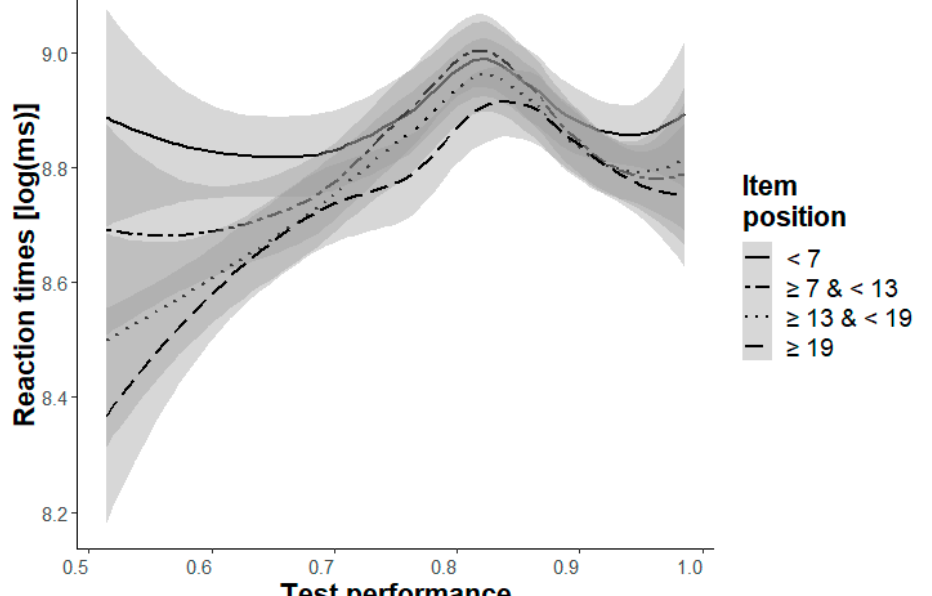
Figure 3. Changes of the logarithmized reaction times depending on test performance (ACC-poss, x-axis) and item position (grouped into four intervals, indicated by four lines) with a .95-confidence- interval for Level d.